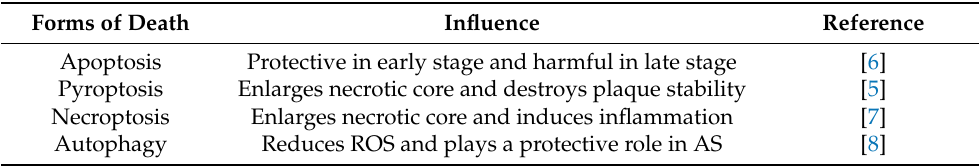
Table 1. Effects of different forms of macrophage death on atherosclerosis. Forms of Death